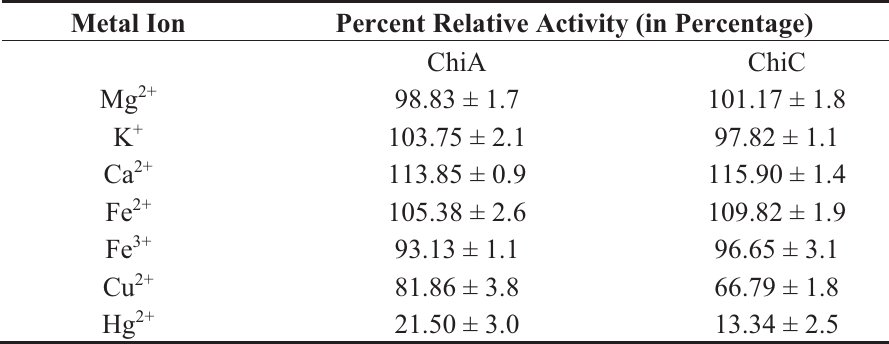
Table 2. Effects of metal ions on chitinase activity.